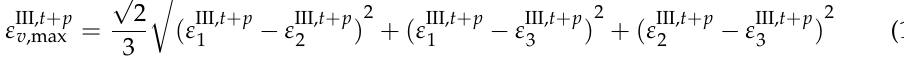
Figure 8. Schematic diagram of the superposition analysis of load influence.